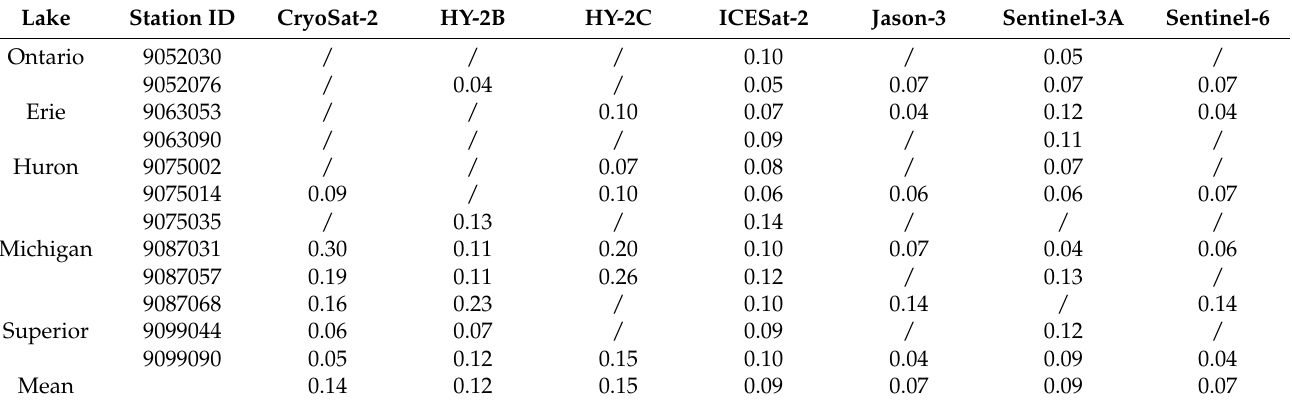
Table 5. RMSE of seven altimetry satellites at twelve stations in the Great Lakes (unit: